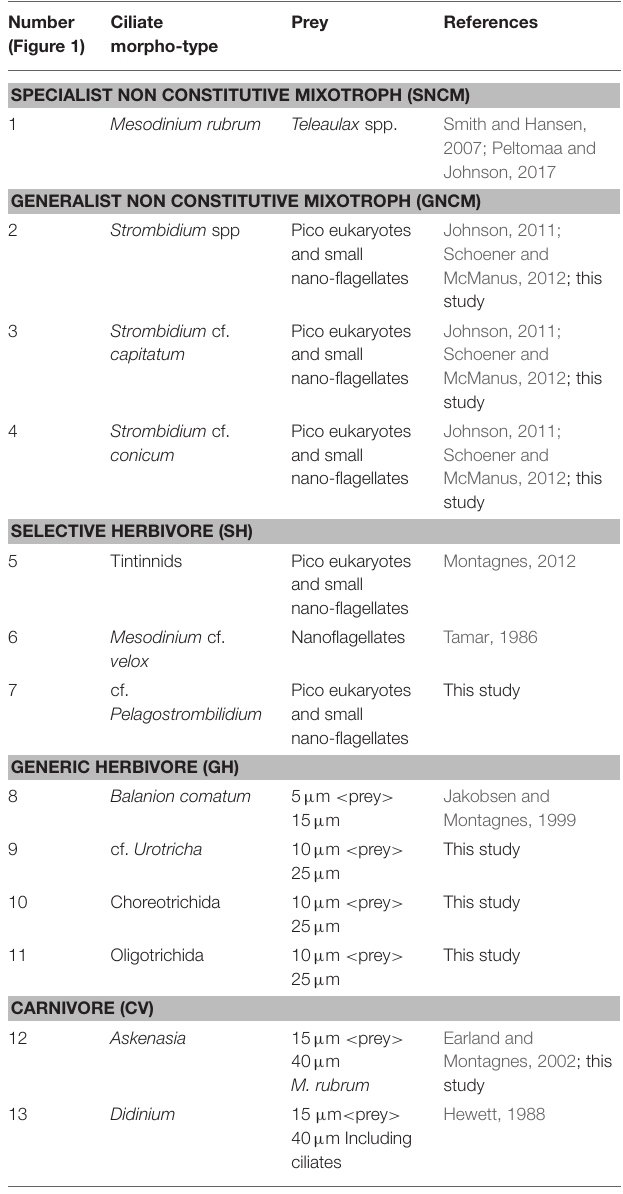
TABLE 1 | Ciliate morpho-types, trophy mode, their assigned potential preys in this study and references used to support preys assignment. Number Ciliate (Figure 1) morpho-type